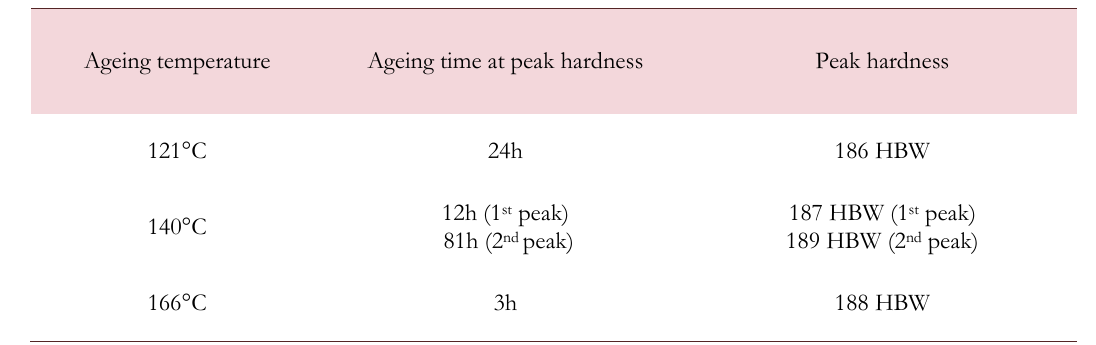
Table 3: Peak hardness and peak hardness times for the ageing temperatures investigated.